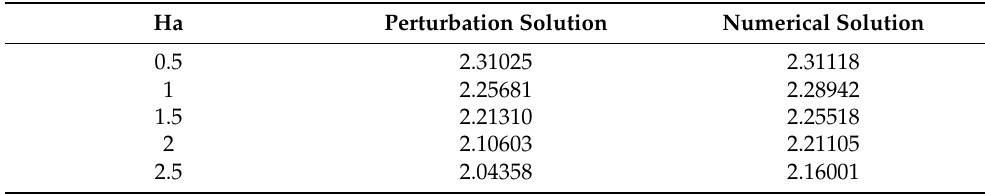
Table 2. The comparison of numerical values of axial velocity distribution ( u ( y )) near the pump center when We = 0.001, ε = 0.25, and n = 0.2.